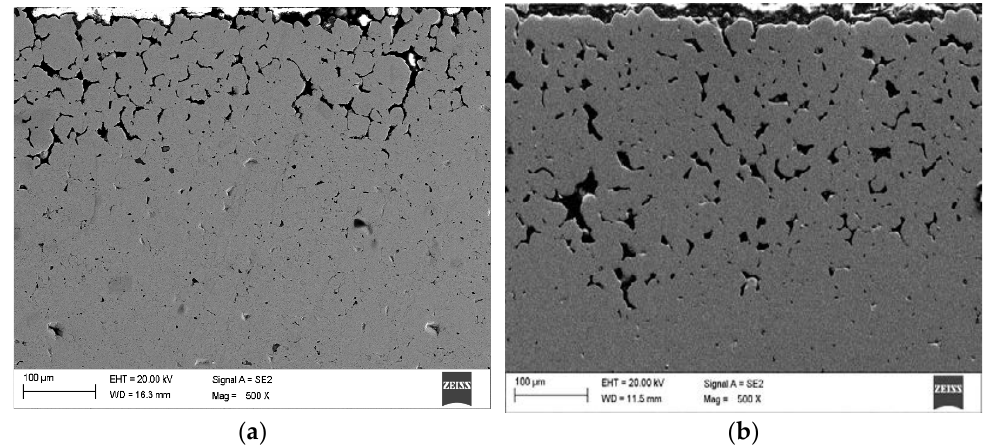
Figure 4. ( a ) Surface layer of sample after debinding under N 2 and sintering at 1350 °C under N 2 -5%H 2 ; ( b ) Surface layer of sample after debinding under Ar-5%H 2 and sintering at 1350 °C under Ar-5%H 2 .